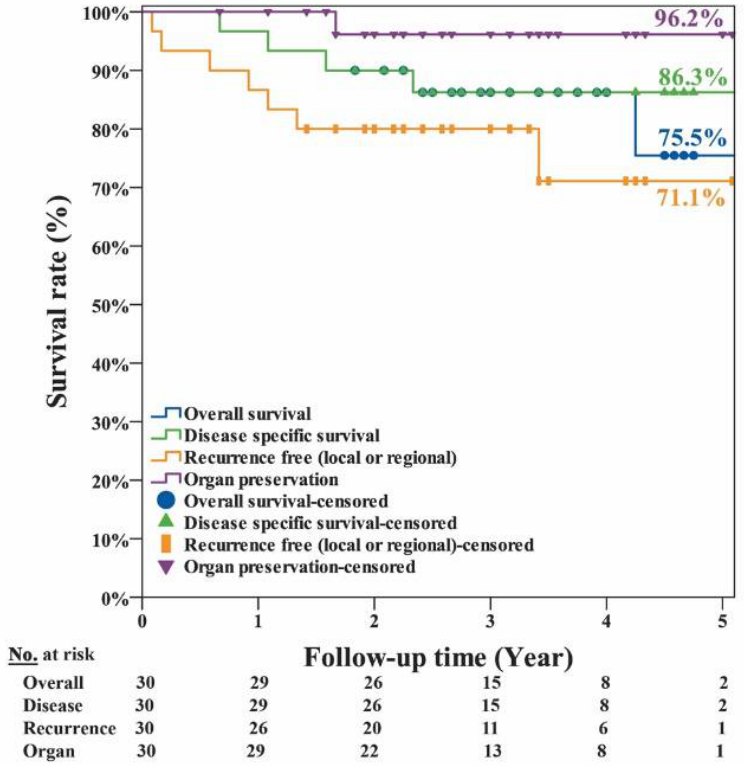
Figure 3. The estimated 5-year overall survival rate was 75.5%; the disease-specific survival rate was 86.3%; the recurrence-free survival rate was 71.1%; and organ preservation rate was 96.2% for the 30 patient cohort of pharyngeal and laryngeal cancers.